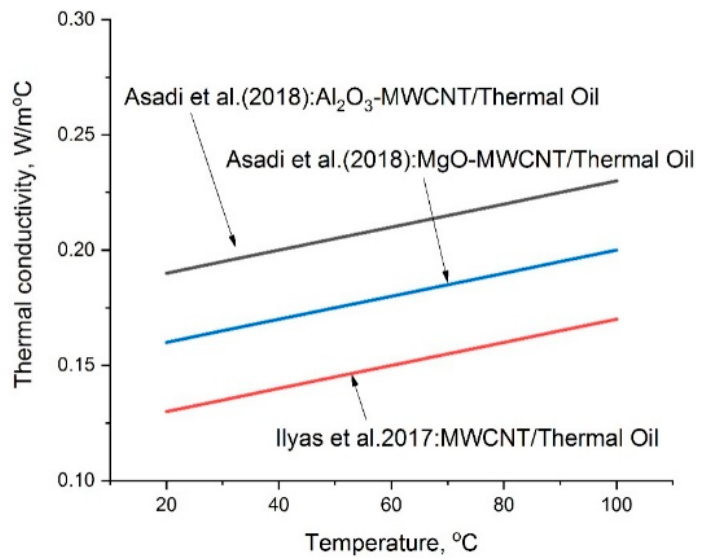
Figure 6. Comparison of thermal conductivity vs. temperature with various nanoparticle/mineral oil.